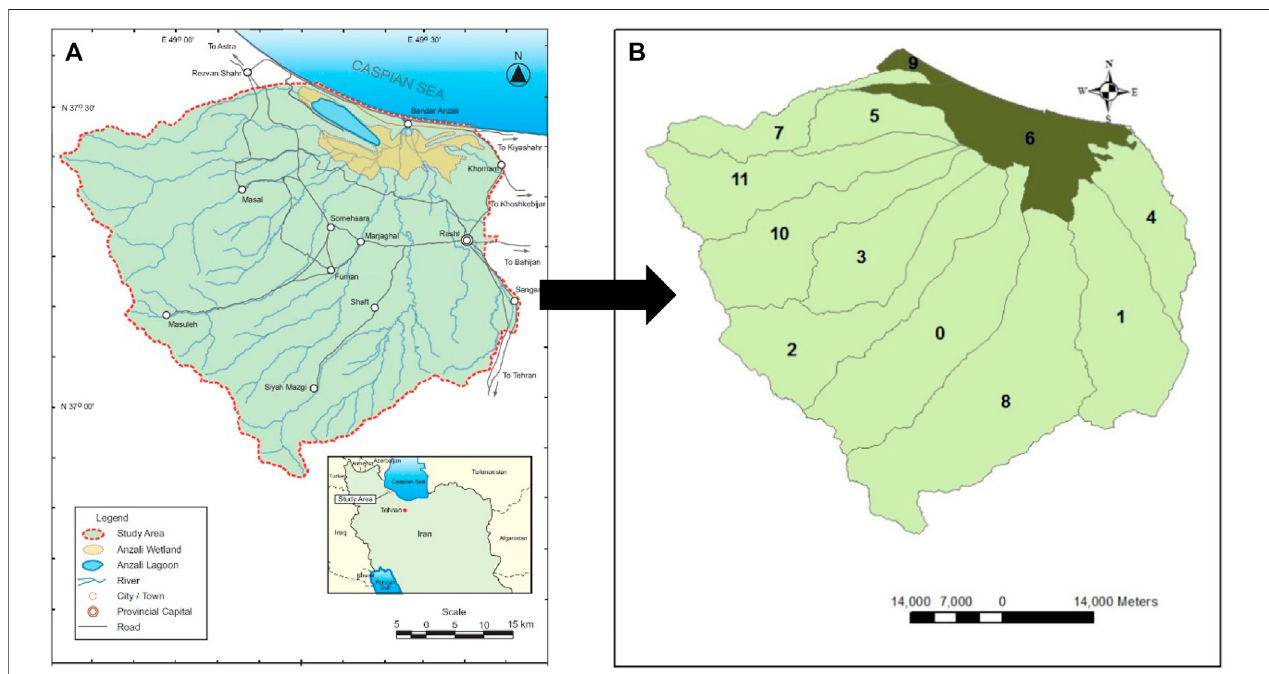
FIGURE 1 | Location of the Anzali watershed (A) showing the twelve sub-watershed divisions (Sw 0 -Sw 11 ) (B) .